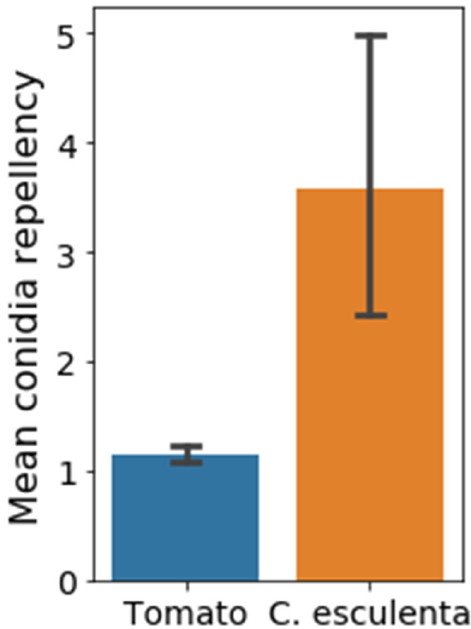
Figure 1. Conidia repellency of two natural surfaces. C. esculenta leaves and tomato leaves were tested for their conidia repellency. Conidia repellency represents the number of conidia counted before wash, divided by the number of conidia counted after wash (BW/AW) on the same surface. Pairs comparison was conducted using Student’s t -test. Conidia repellency values of C. esculenta leaves (3.57 ± 0.69) were significantly higher than those of tomato leaves (1.15 ± 0.04) ( p < 0.01, Bars represent STD).